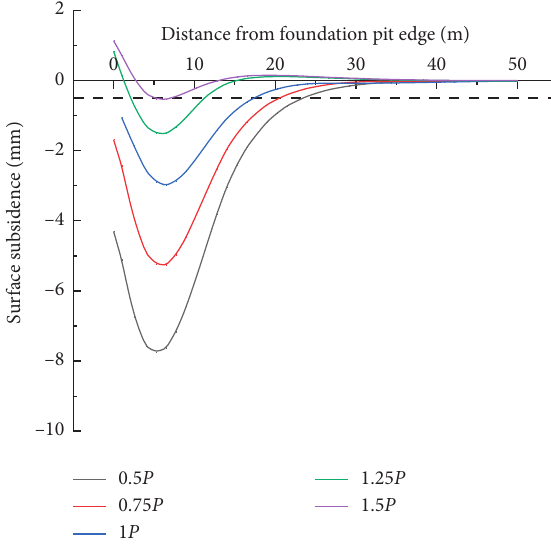
Figure 6: Surface subsidence outside the pit.